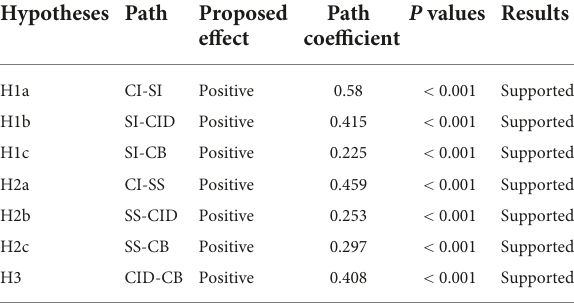
TABLE 4 Hypothesis testing